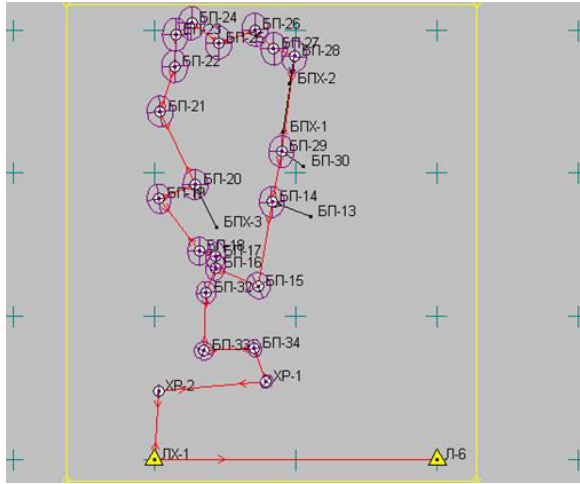
Fig. 2. Scheme of the underground geodetic network Point of beginning for the coordinate system was chosen arbitrarily, but an appropriate connection with the above-ground geodetic network was established. It was done just for control. Topcon GPT-6001C total station (Fig. 3) was used to create the underground geodetic network and the referencing of scanning targets. All angular measurements were completed with at least four repetitions, the length of the lines measured in the forward and reverse directions, with an accounting of all the necessary corrections.